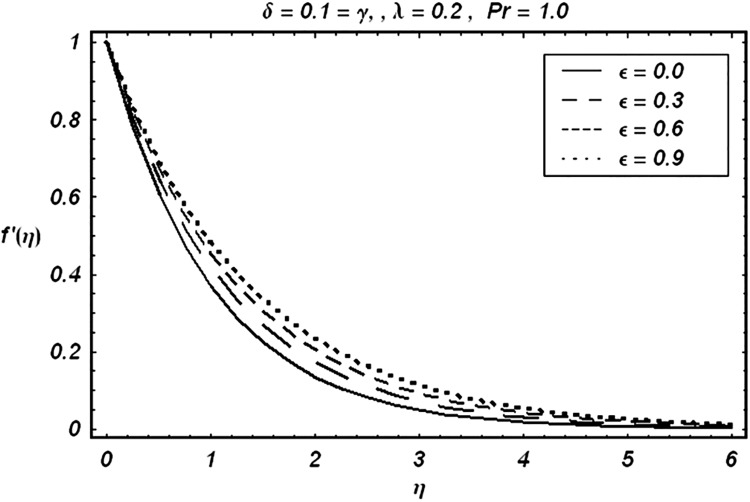
Variation of ε on f′.